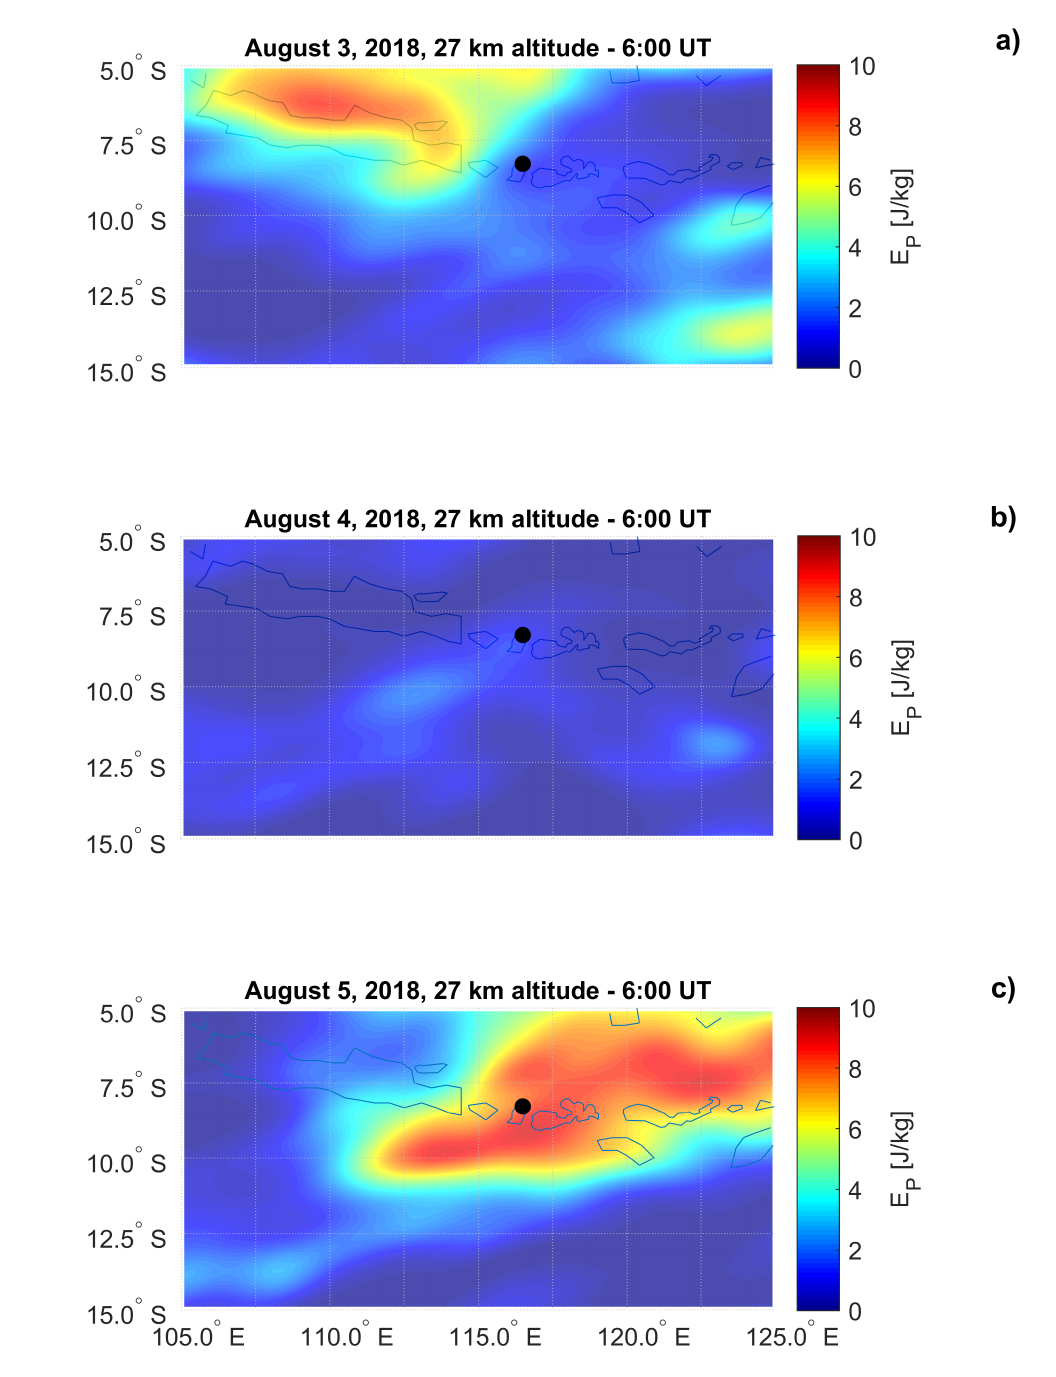
Figure 6. Pre-seismic E P maps from 3 to 5 August 2018. The date and altitude are indicated in each panel ( a – c ). The earthquake epicenter is marked by a black dot.